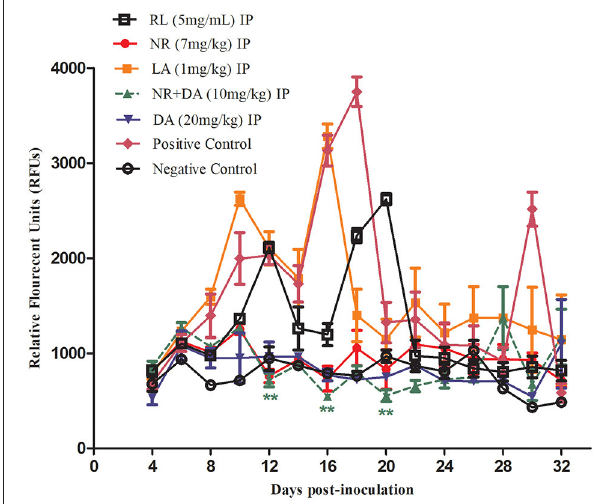
FIGURE 4 | Chemotherapeutic evaluation (RFUs) of RL, NR, and LA in mice.